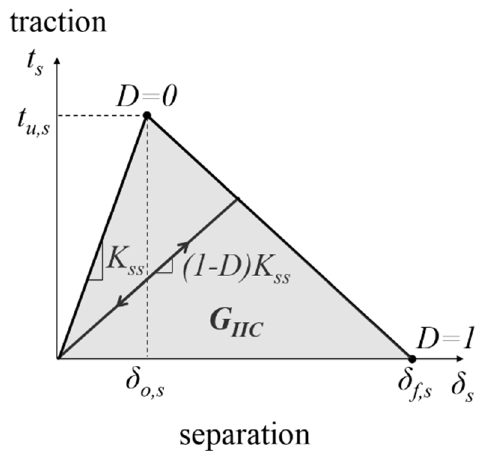
Figure 9. Schematic diagram of the bilinear traction separation law.